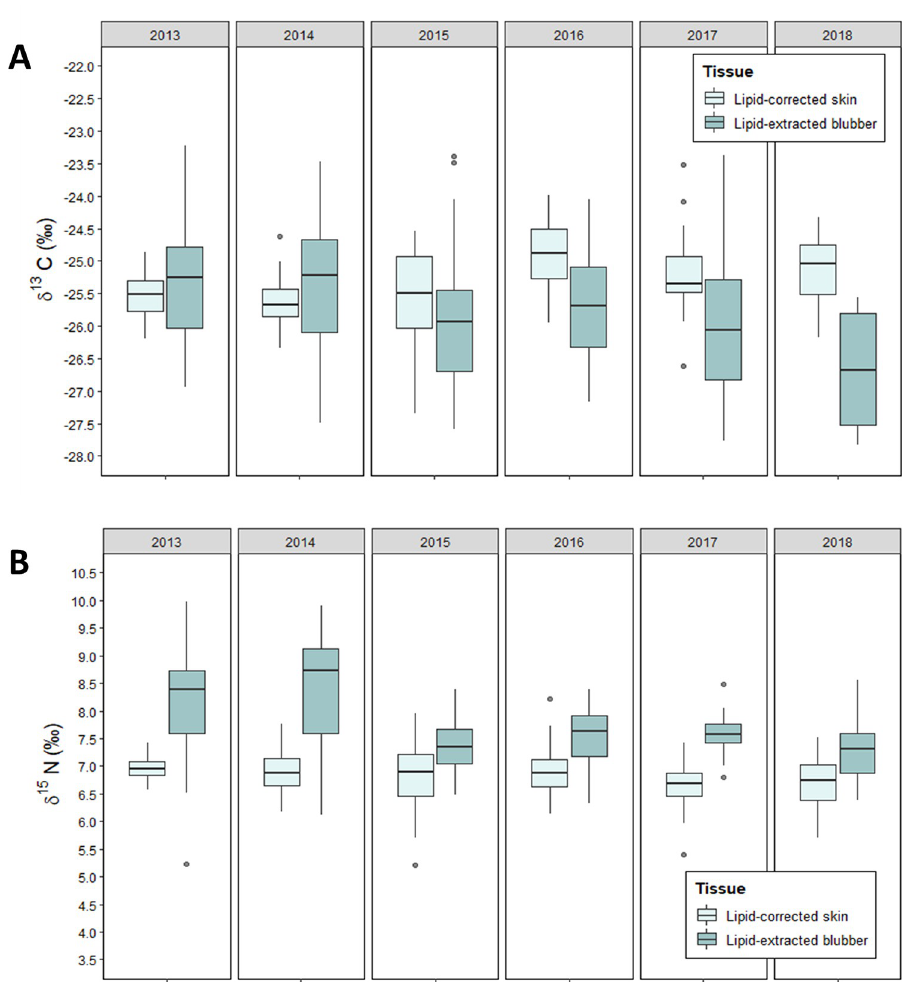
Fig 2. Isotopic values of blubber and skin (n = 171) across all sample years. (A) illustrates comparison between both tissues for δ 13 C and (B) for δ 15 N